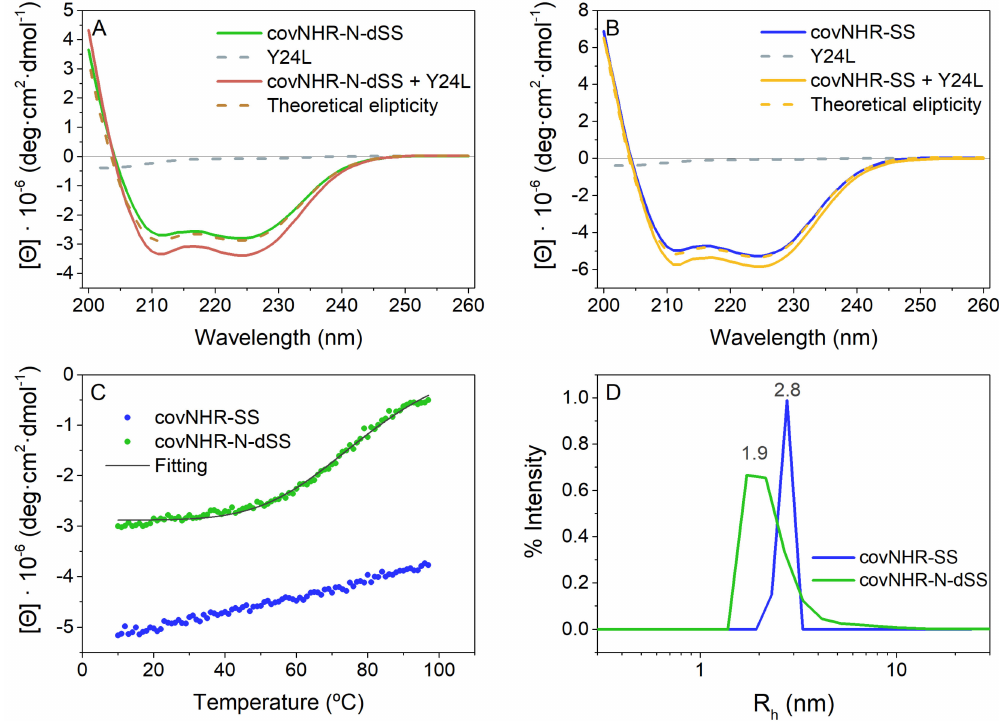
Figure 3. Secondary structure and thermal stability of covNHR-N-dSS (green) and covNHR-SS (blue). ( A ) Far UV CD spectra of free covNHR-N-dSS (green, solid line) and ( B ) covNHR-SS (blue, solid line) and in a (1:2) mixture with their complementary CHR peptide, Y24L (red and yellow lines, respectively). Y24L peptide alone is shown in dashed grey lines in both panels. The red and yellow dashed lines represent the theoretical sum of the spectra of the free molecules. ( C ) Thermal unfolding of covNHR-N-dSS (green symbols) and covNHR-SS (blue symbols) followed by monitoring the CD signal at 222 nm. The grey solid line corresponds to the best fitting carried out using a two-states unfolding model. ( D ) Particle size distributions measured by dynamic light scattering with solutions of covNHR-N-dSS (green) and covNHR-SS (blue). All experiments were carried out at pH 7.4 in 50 mm sodium